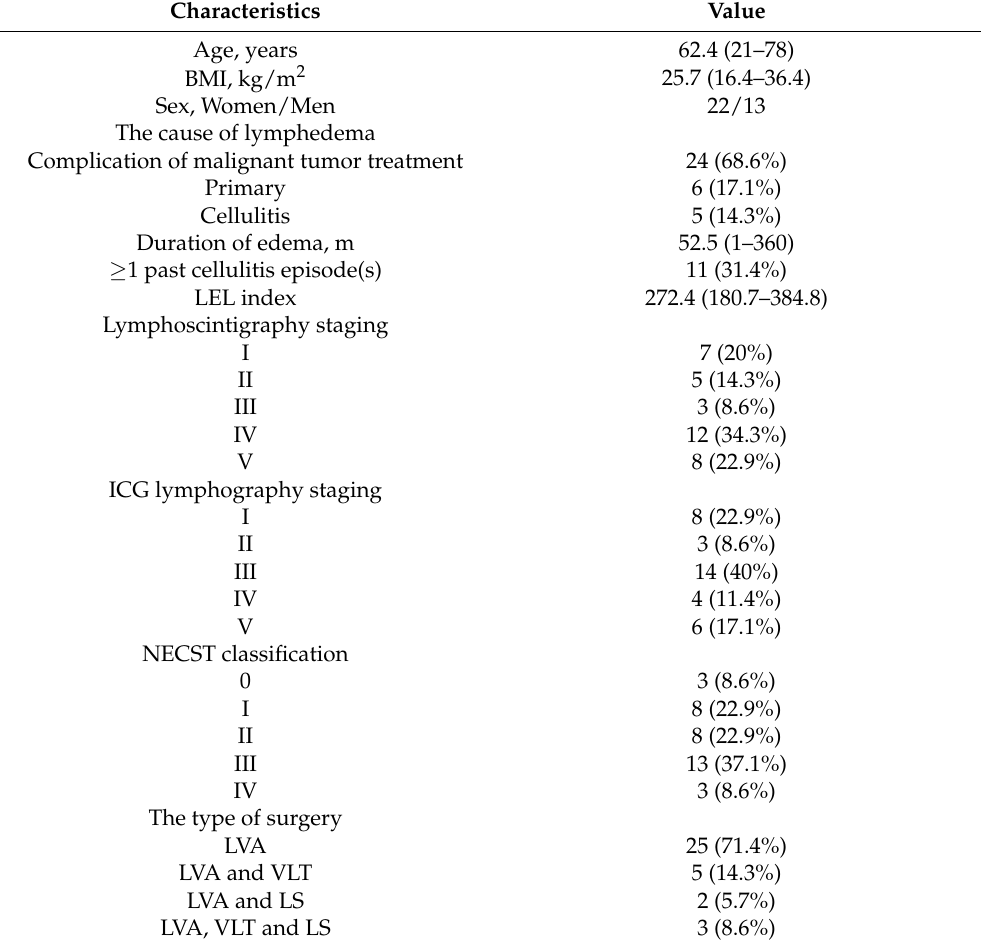
Table 1. Clinical characteristics of the